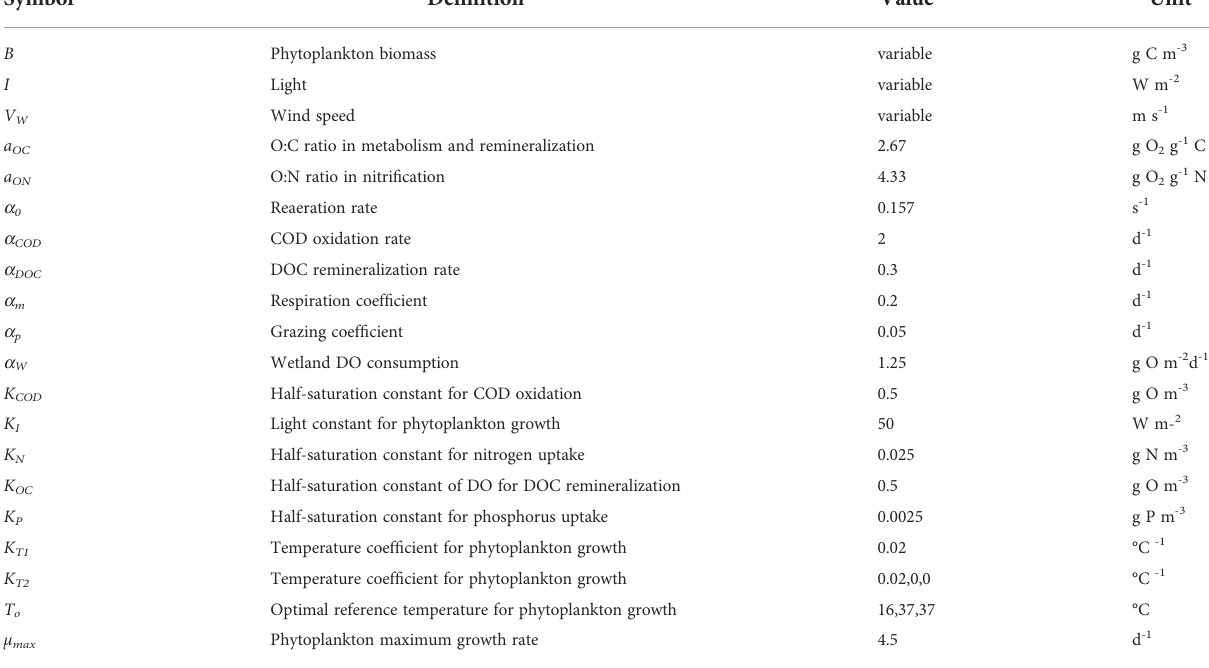
TABLE 1 Parameter de fi nition, values and units of the water quality model (Cerco and Noel, 2004).